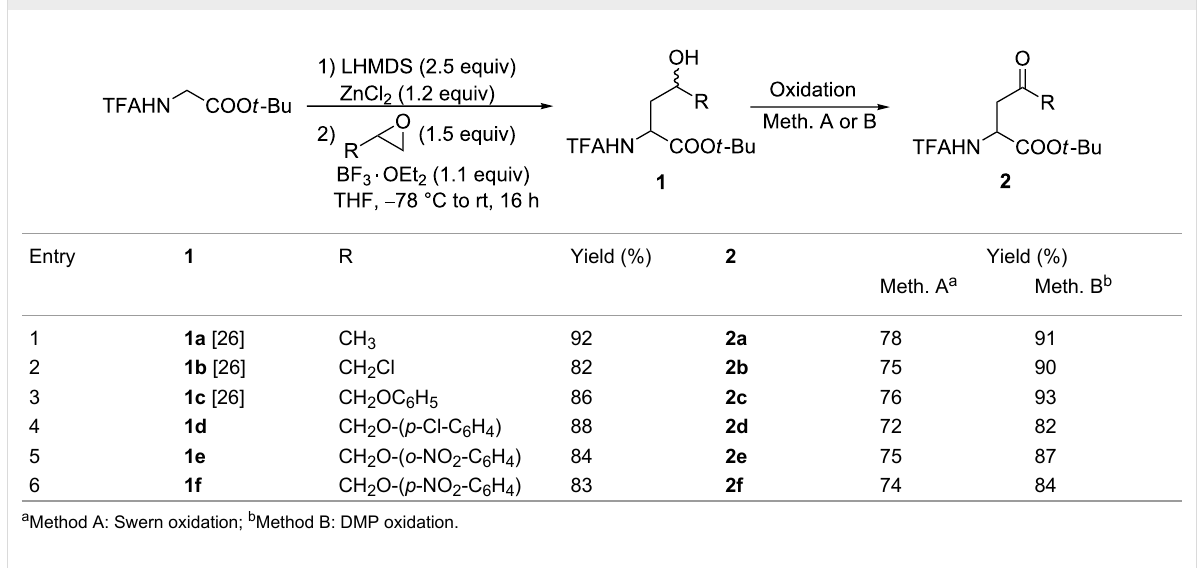
Table 1: Synthesis of γ -oxo-amino acids.